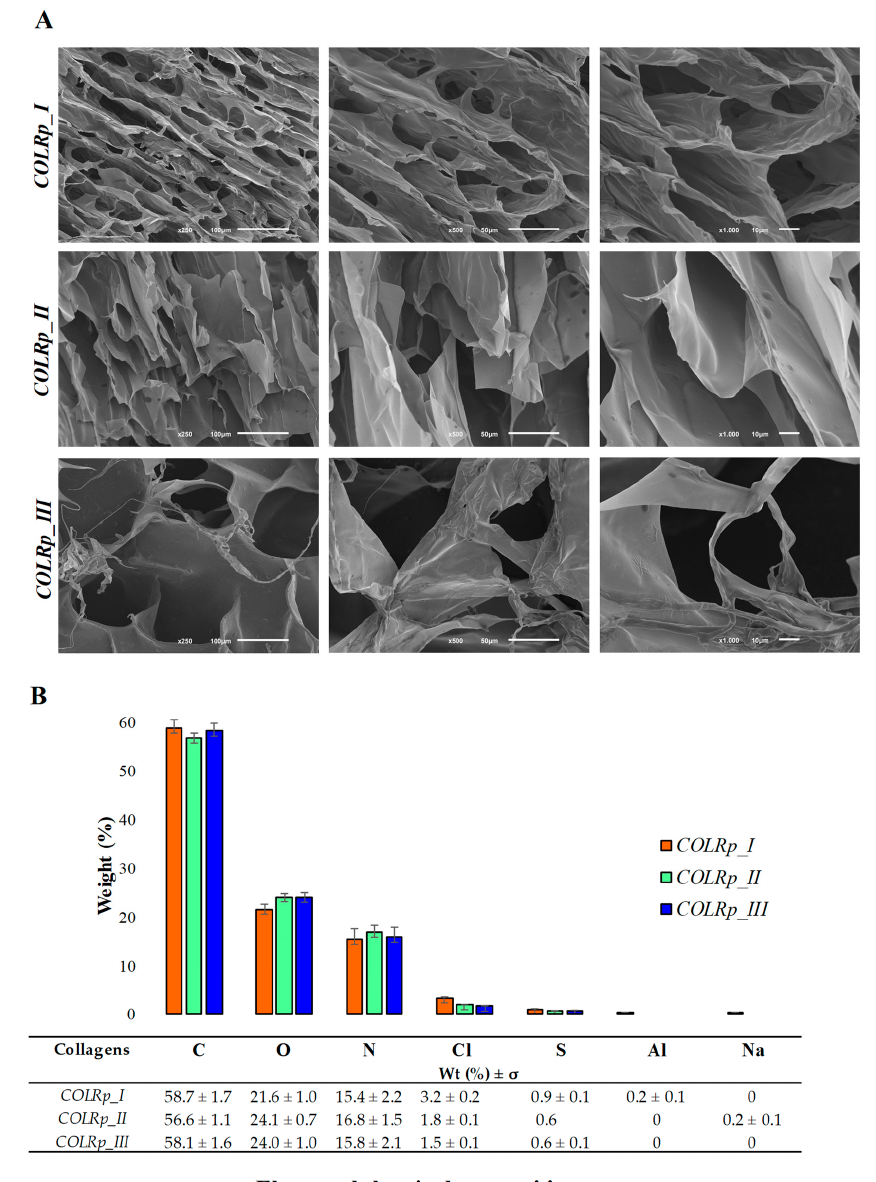
Figure 4. SEM and EDS analyses of Greenland halibut skin collagens, with observation of morpho- logical features and quantification of the elemental composition.